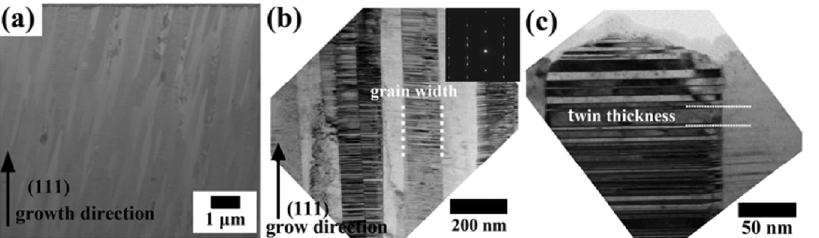
Fig. 1 (a) Representative FIB cross-sectional image and (b and c) cross-sectional TEM images of a NT Cu-2wt.%Al alloy. Inset is selected area electron diffraction (SAED) pattern.